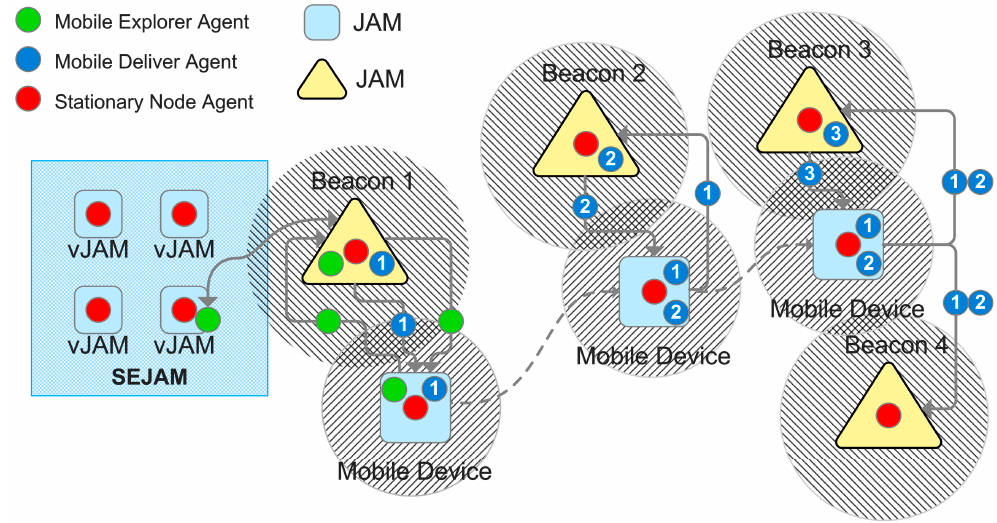
Figure 8. Virtual simulator world connected to spatially distributed non-mobile beacons, mobile devices connected temporarily to beacons (cellular or local WIFI networks), and mobile agents (crowd sensing and chat bots) used for wide-range interaction .